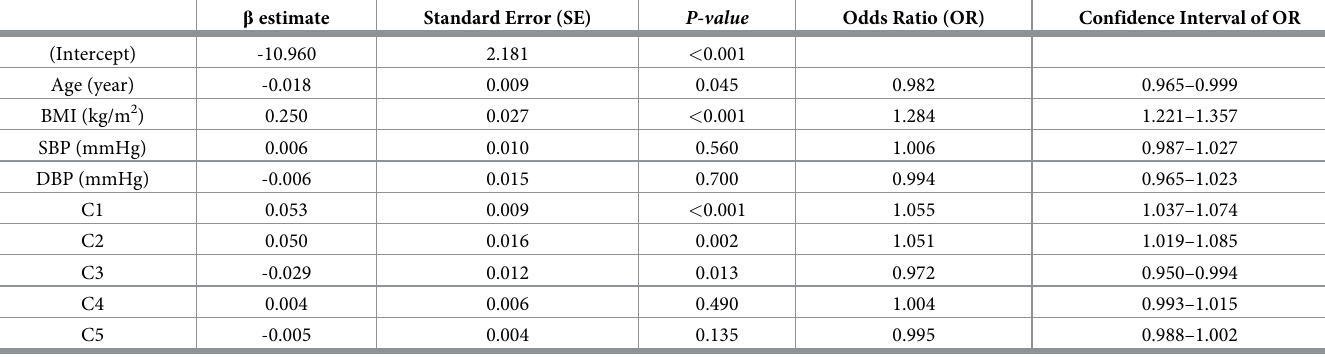
Table 2. Result of logistic regression model: Age, BMI, C1, C2 and C3 for type 2 diabetes (N = 808, age 20–95). β